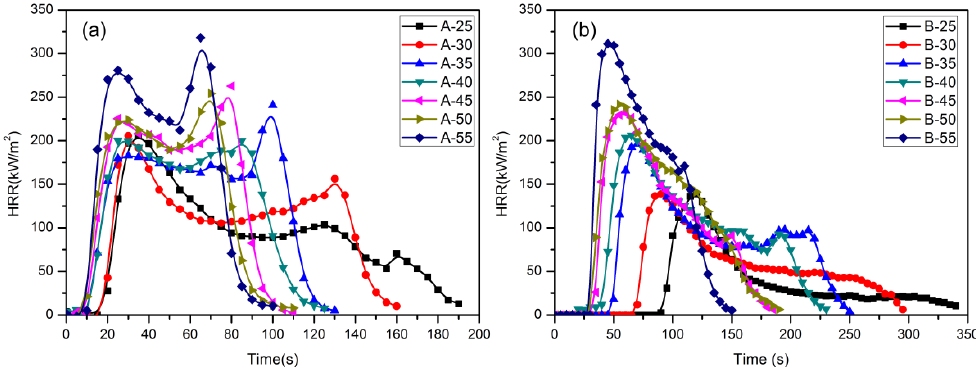
Figure 4. The HRR profile of material A ( a ); and material B ( b ) under different heat fluxes.